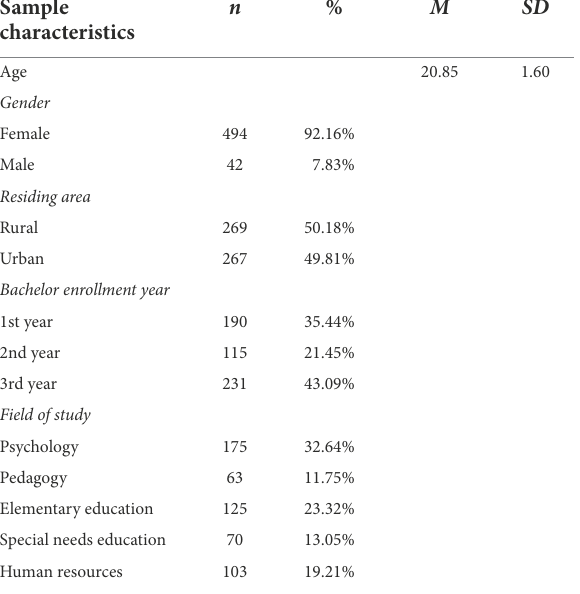
TABLE 1 Participants characteristics. Sample